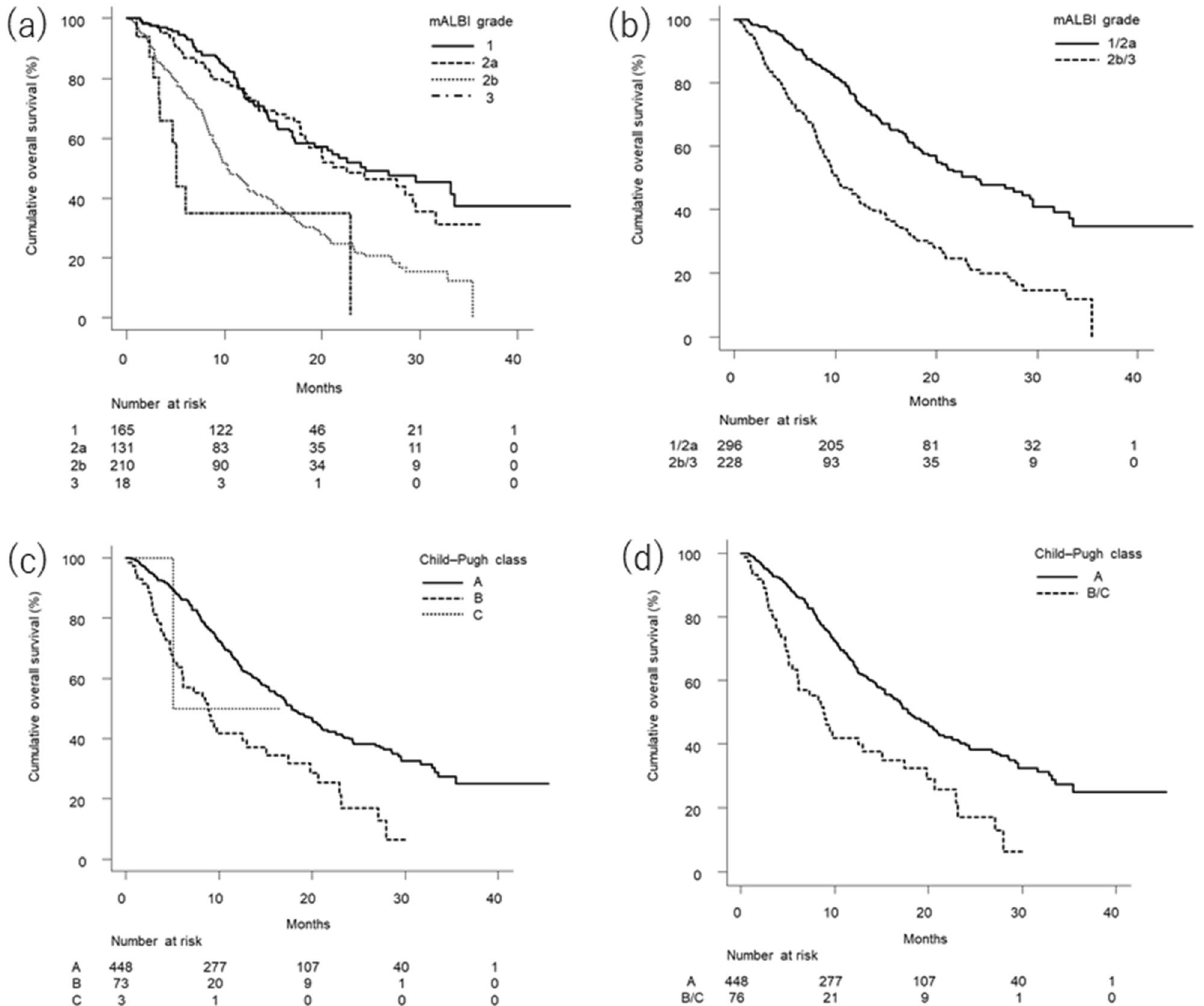
Figure 1. Cumulative survival curves for all study patients. ( a ) By mALBI grade. There was a significant difference in cumulative overall survival among patients grouped by mALBI grade ( p < 0.001). The median survival times of patients with mALBI grades 1, 2a, 2b, and 3 were 24.4 (95%CI, 17.2—not available), 22.5 (95%CI, 18.3–29.5), 10.3 (95%CI, 9.1–12.5), and 5.1 (95%CI, 3.3—not available) months, respectively. Multiple comparisons between mALBI grades 1 and 2a, 1 and 2b, 1 and 3, 2a and 2b, 2a and 3, and 2b and 3 demonstrated p values of 1.000, < 0.001, < 0.001, < 0.001, < 0.001, and 0.654, respectively. ( b ) By mALBI grade divided into 1/2a and 2b/3. There was a significant difference in cumulative overall survival between patients with mALBI grades 1/2a and 2b/3 ( p < 0.001). The median survival times in patients with mALBI grades 1/2a and 2b/3 were 23.9 (95%CI, 20.0–29.5) and 10.1 (95%CI, 8.9–12.4) months, respectively. ( c ) By Child–Pugh classification. There was a significant difference in cumulative overall survival among patients stratified by Child–Pugh classification ( p < 0.001). The median survival times in patients with Child–Pugh classes A, B, and C were 17.8 (95%CI, 16.0–20.8), 8.8 (95%CI, 6.0–12.9), and 5.1 (95%CI, 5.1—not available) months, respectively. Multiple comparisons between Child–Pugh classes A and B, A and C, and B and C demonstrated p values of < 0.001, 1.000, and 1.000, respectively. ( d ) By Child–Pugh classification divided into A and B/C. There was a significant difference in cumulative overall survival between patients with Child–Pugh classes A and B/C ( p < 0.001). The median survival times in patients with Child–Pugh classes A and B/C were 17.8 (95%CI, 16.0–20.8) and 8.8 (95%CI, 6.0–15.0) months, respectively. mALBI Modified albumin–bilirubin, CI Confidence using time-dependent ROC analysis. The AUCs at 3, 6, 9, 12, 15, 18, 21, and 24 months were 0.738, 0.719, 0.712, 0.673, 0.663, 0.658, 0.664, and 0.671, respectively. Figure 4 shows AUROC plots of the ALBI and Child–Pugh scores for overall survival from 3 to 24 months after the start of follow-up, as analyzed by time-dependent ROC. The ALBI score had better predictive ability for overall survival than the Child–Pugh score at all time points. Table 3 shows the sensitivity, specificity, and cut-off values of the ALBI and Child–Pugh scores at 6, 12, 18, and 24 months according to time-dependent ROC analysis for overall survival. The optimal cut-off values of the ALBI